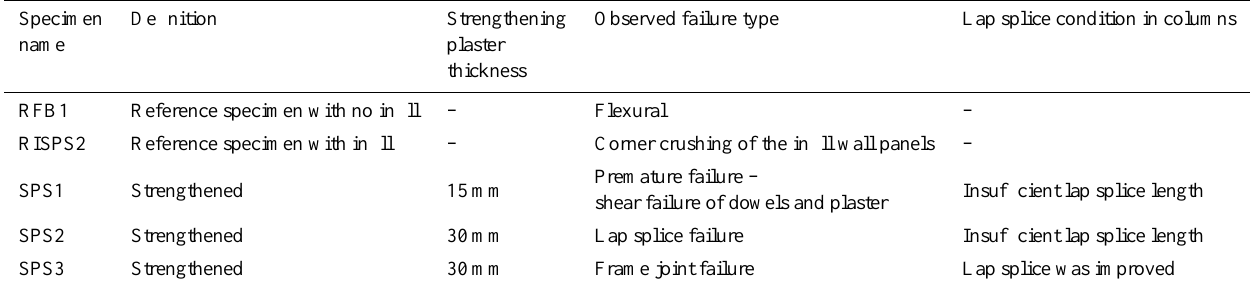
Table 1. Summary of the test